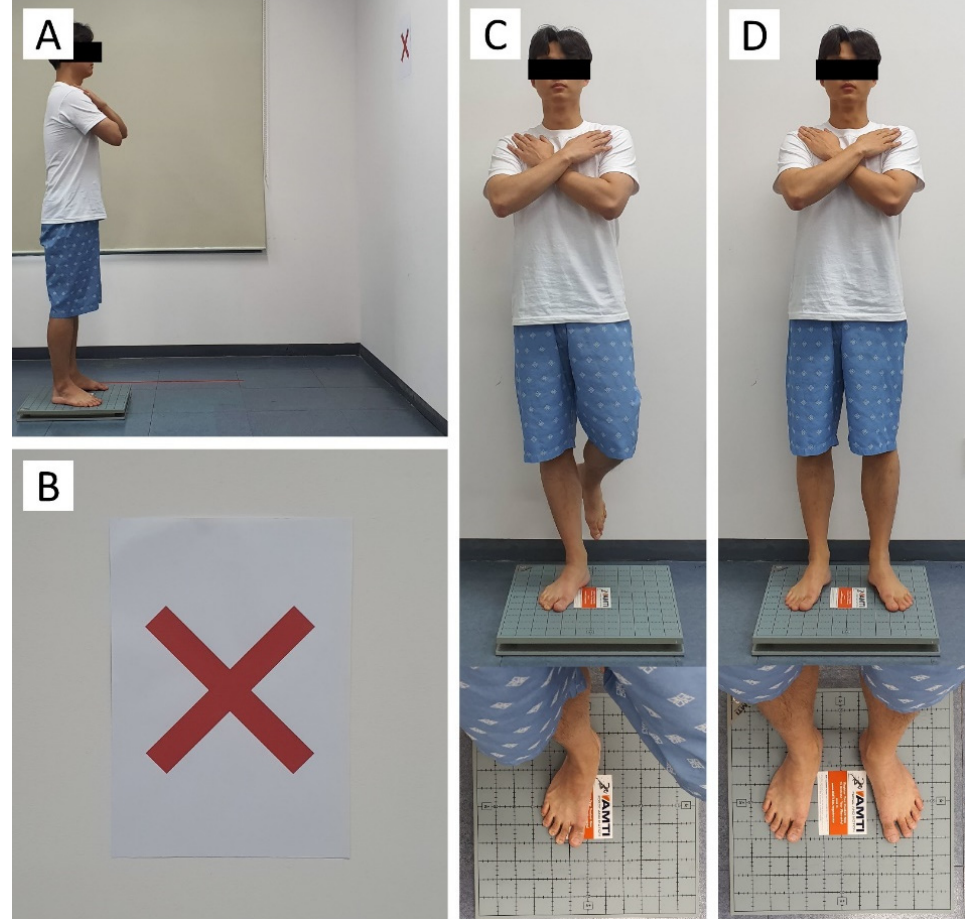
Figure 2. Static balance measurement. ( A ), Balance measuring environment. ( B ), X-shaped target. ( C ). One-legged standing posture, ( D ), Two-legged standing posture.